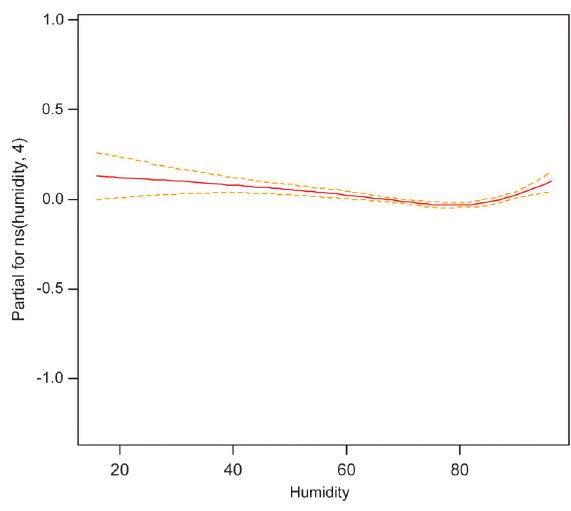
Figure 7. Time trend function (7 degrees of freedom).